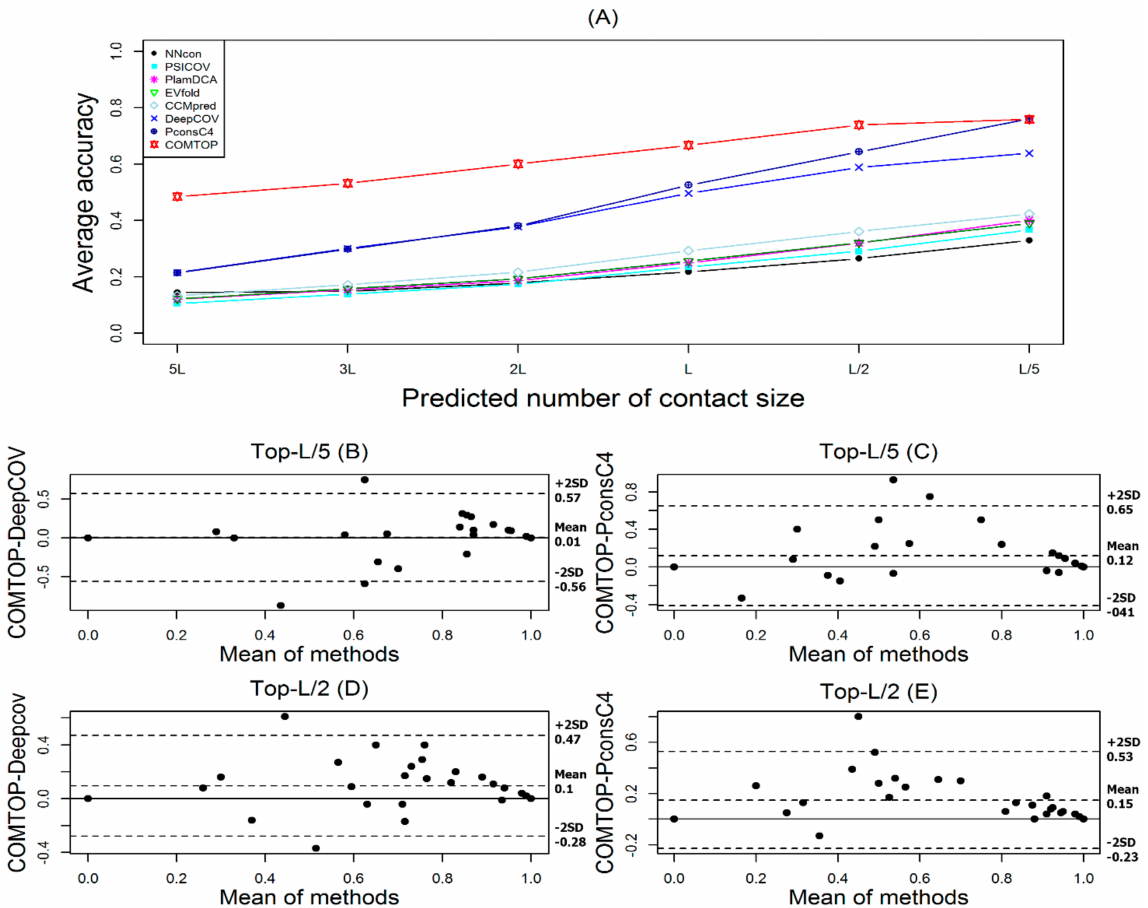
Figure 5. The overall performance of the COMTOP model. ( A ): the prediction accuracy of COMTOP with seven individual methods against predicted number of protein contacts size for CASP13 dataset. ( B , D ): Bland–Altman plots between COMTOP and DeepCov, with the representation of the limits of agreement (dotted line), from +2SD to − 2SD. ( C , E ): Bland– Altman plots between COMTOP and PconsC4, with the representation of the limits of agreement (dotted line), from +2SD to − 2SD.